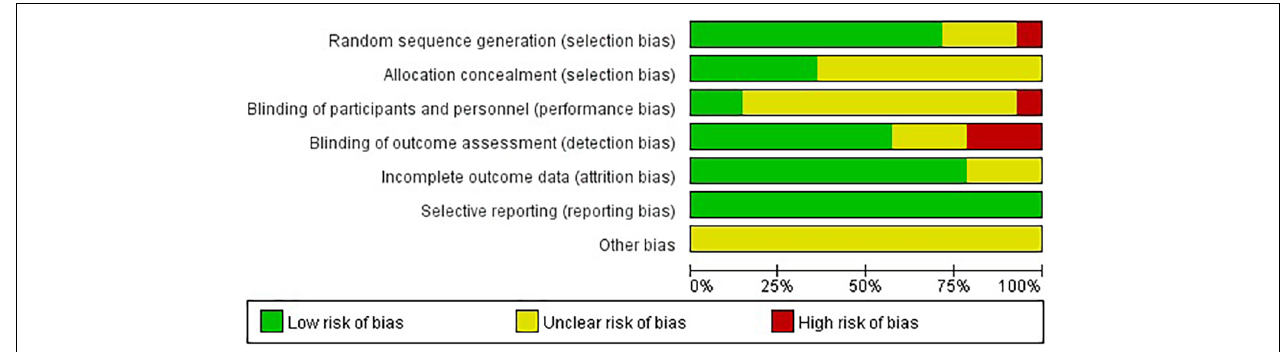
FIGURE 3 | The risk of bias for the included